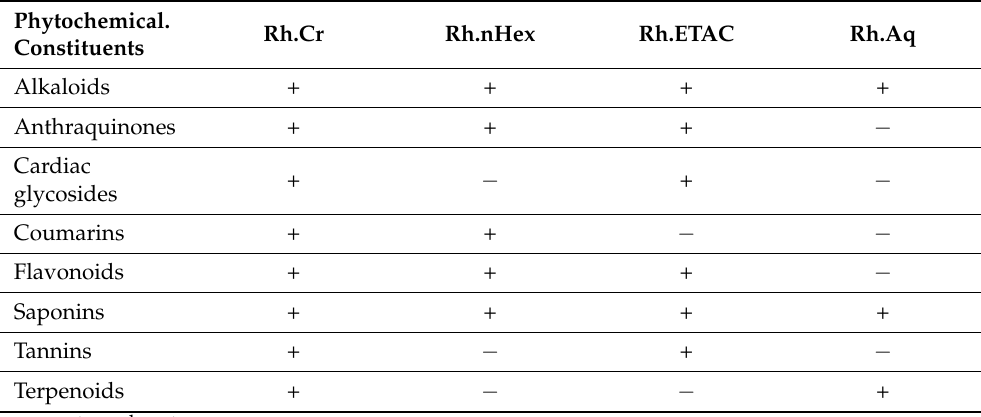
Table 1. Phytochemical analysis of Rumex hastatus crude extract (Rh.Cr) and fractions: n-hexane (Rh.n-Hex), ethyl acetate (Rh.ETAC) and aqueous (Rh.Aq).